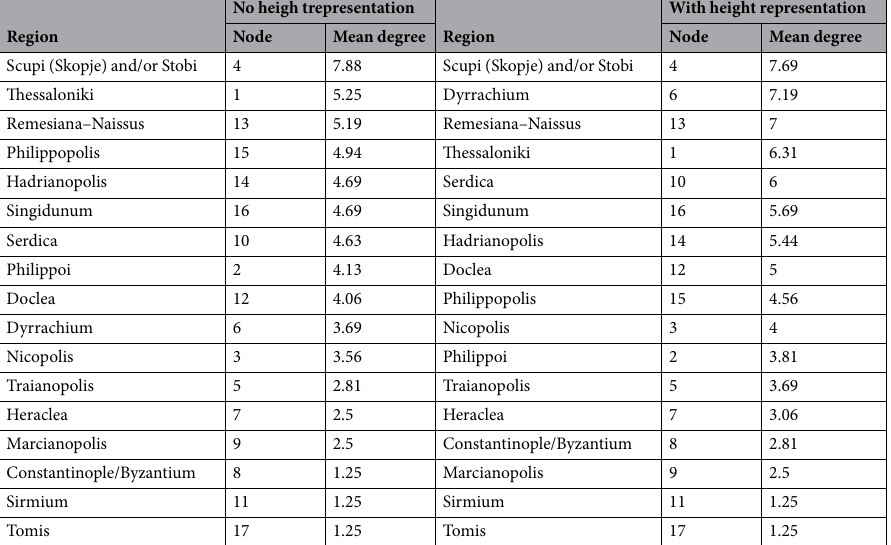
Table 1. Mean degree of region connectivity over 20 experiments ranked in descending order with no height representation (left) and with height representation